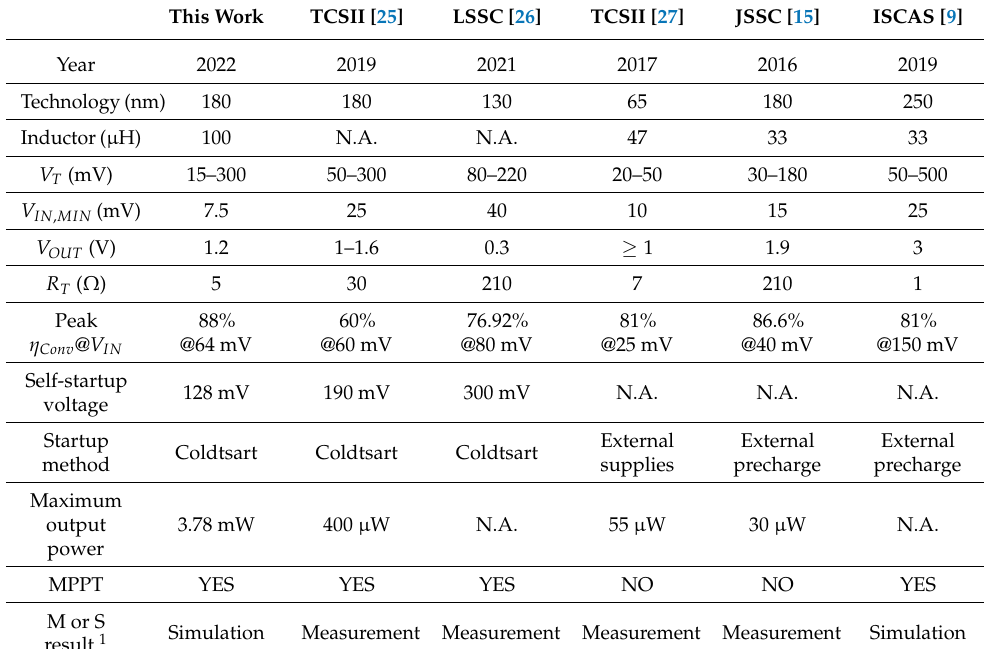
Table 4. Performance